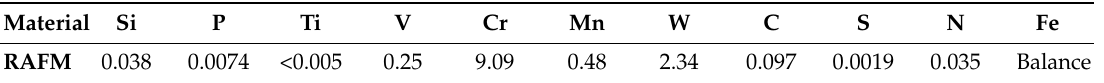
Table 1. Chemical composition of the steel in the present study (wt. %).